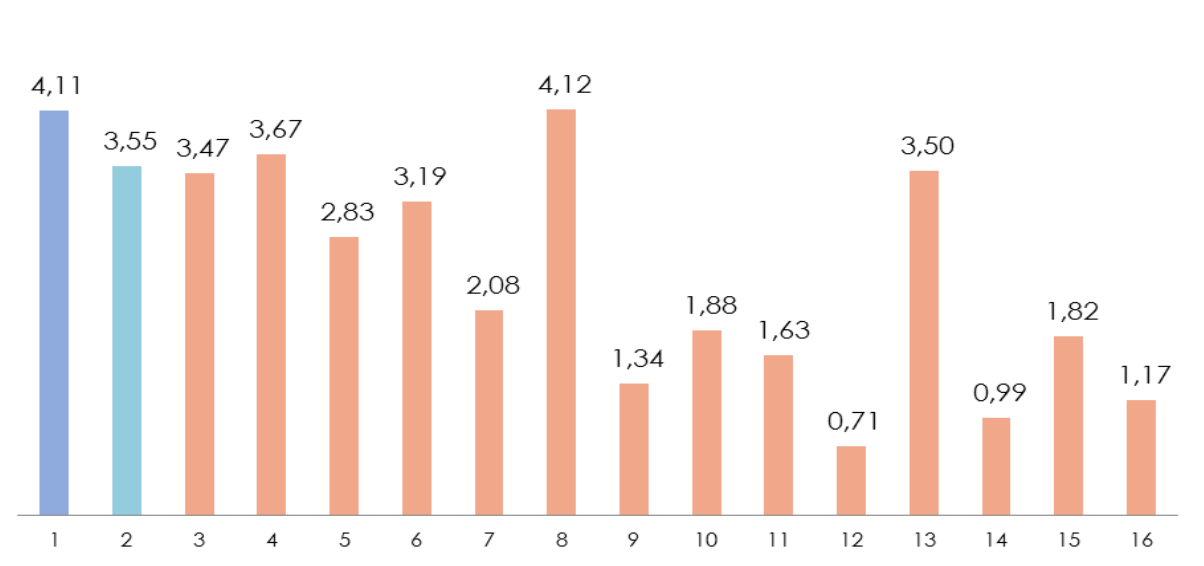
Figure 4. Relative risk of social exclusion per Medellín District, 2012 (author